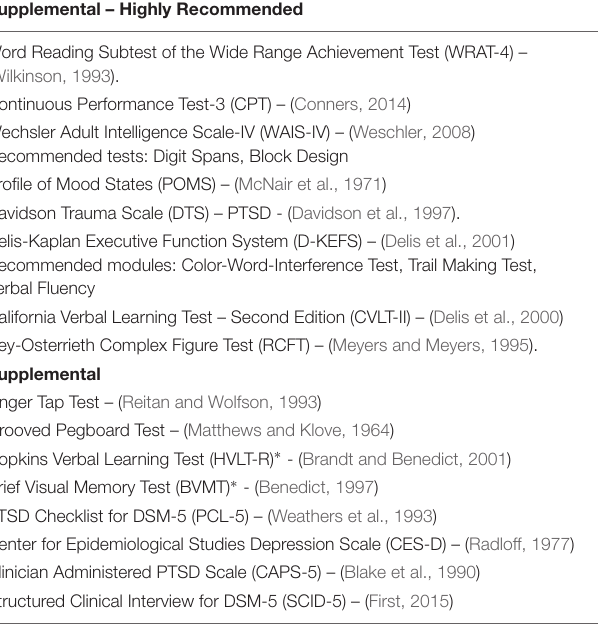
TABLE 1 | Gulf War illness common data elements module: neuropsychological test